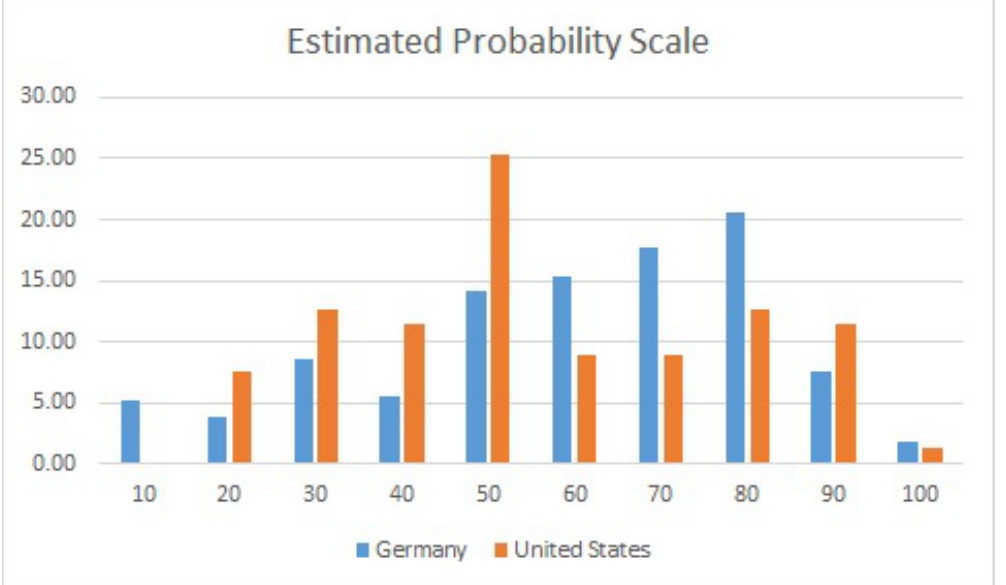
Figure 2. Estimated probability scale. Answers to the question: “What likelihood of child abuse (0–100%) would be necessary to have “reasonable suspicion” / “gewichtige Anhaltspunkte” of abuse?”